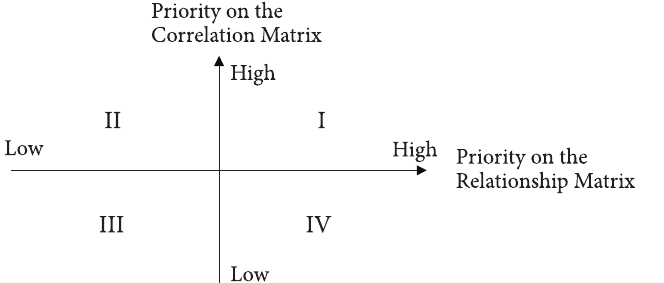
Fig. 4. Synergistic analysis for solution